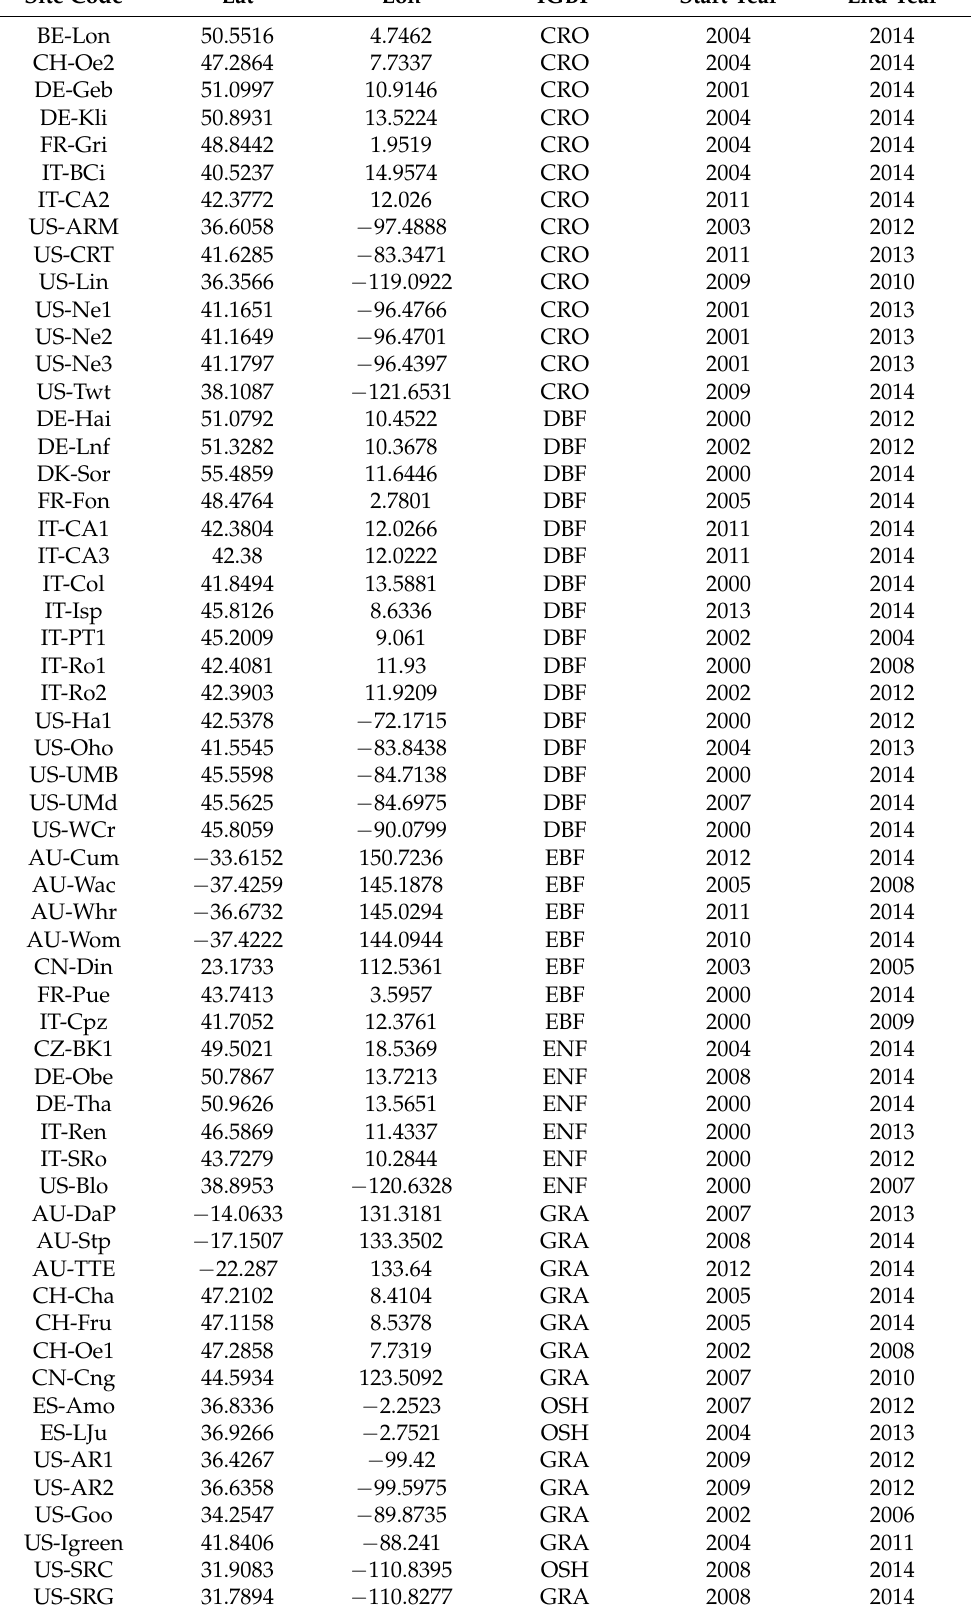
Table A1. List of eddy covariance sites after quality control